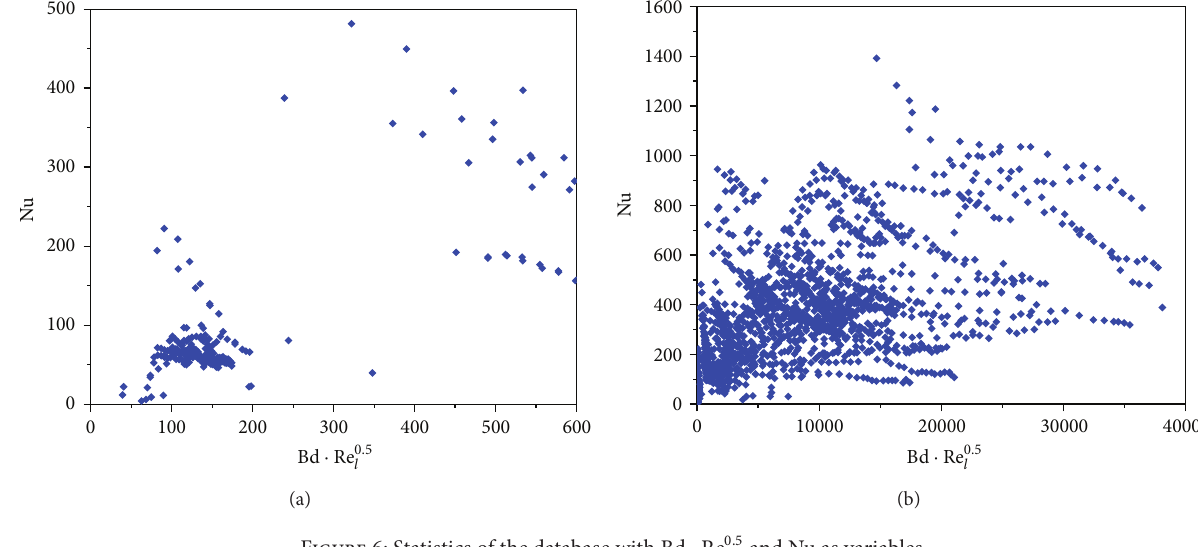
Figure 6: Statistics of the database with Bd ⋅ Re 0.5 𝑙 and Nu as variables.